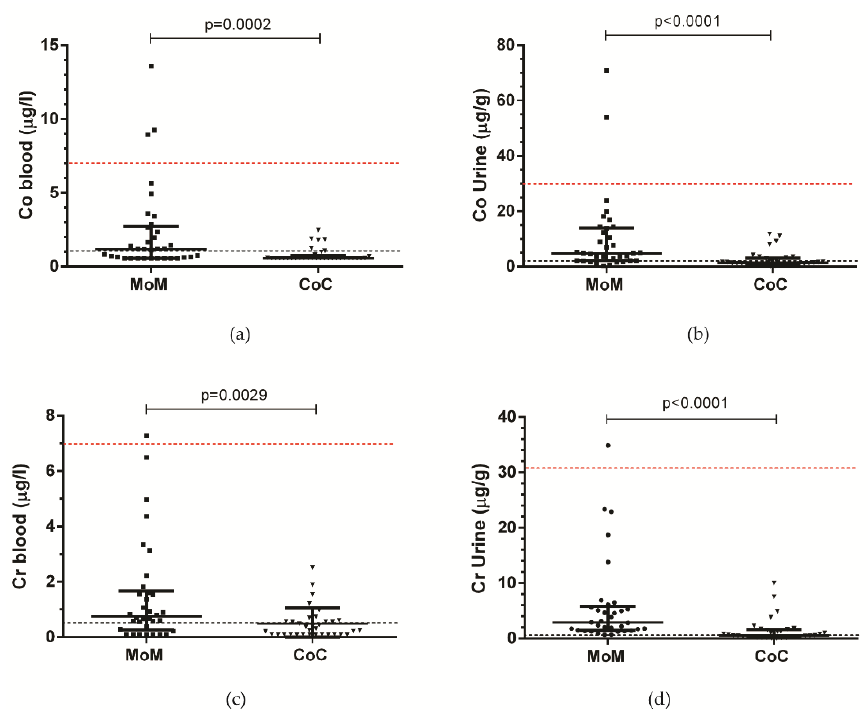
Figure 5. Scatter dot plot (median with interquartile range) of metal ion levels in MoM and CoC groups. Cobalt ion level in whole blood ( a ) and urine ( b ). Chromium ion level in whole blood ( c ) and urine ( d ). Urinary values are expressed as μg/g of creatinine. Dotted lines represent the laboratory upper limits of the normal range in the general population for cobalt and chromium in whole blood (1 and 0.5 µg/l, respectively). Dotted red lines represent the safety threshold of 7 μg/l for Co and Cr in whole blood. In urinary levels normalized to creatinine ( b and d ), dotted lines represent the normal values of CoU < 2 µg/g and CrU < 0.05 according to the National Institute for Research and Safety (Institut national de recherche et sécurité (INRS)). Dotted red lines represent the safety threshold of 30 μg/l for Co and 31 for Cr in urine.